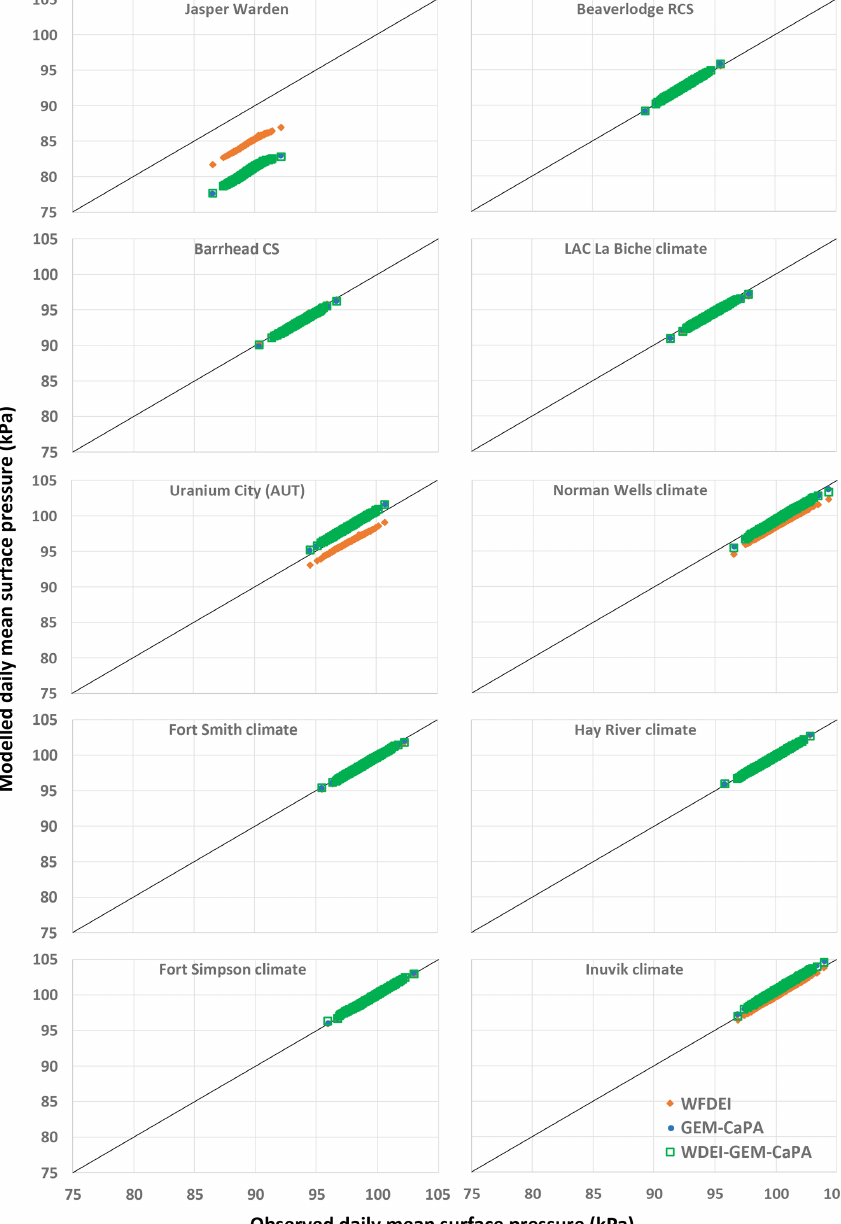
Figure 8. Quantile–quantile plots of modelled (GEM-CaPA, WFDEI, and WFDEI-GEM-CaPA) and observed daily mean surface